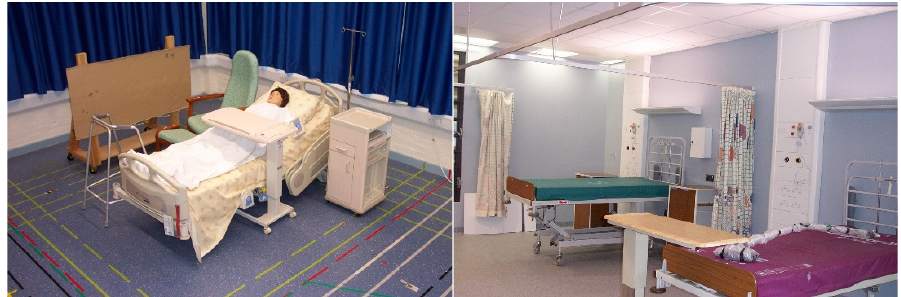
Figure 1. A simple PMU and a fully furnished and equipped